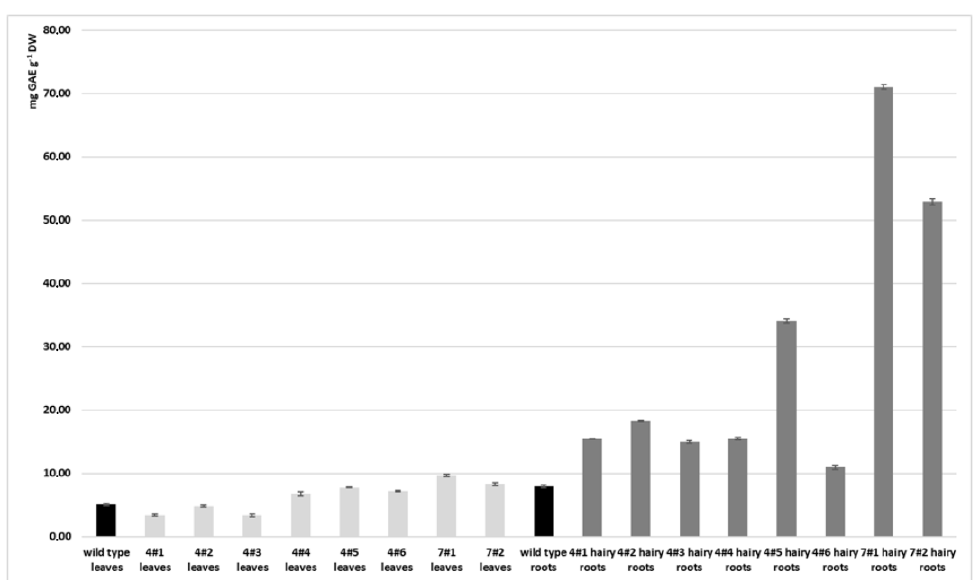
Figure 3. Total polyphenol content measured in hairy roots and composite plants of S. purpurea . The levels of polyphenols were analyzed as described in Section 2. The data ( ± SD) were obtained from three samples per